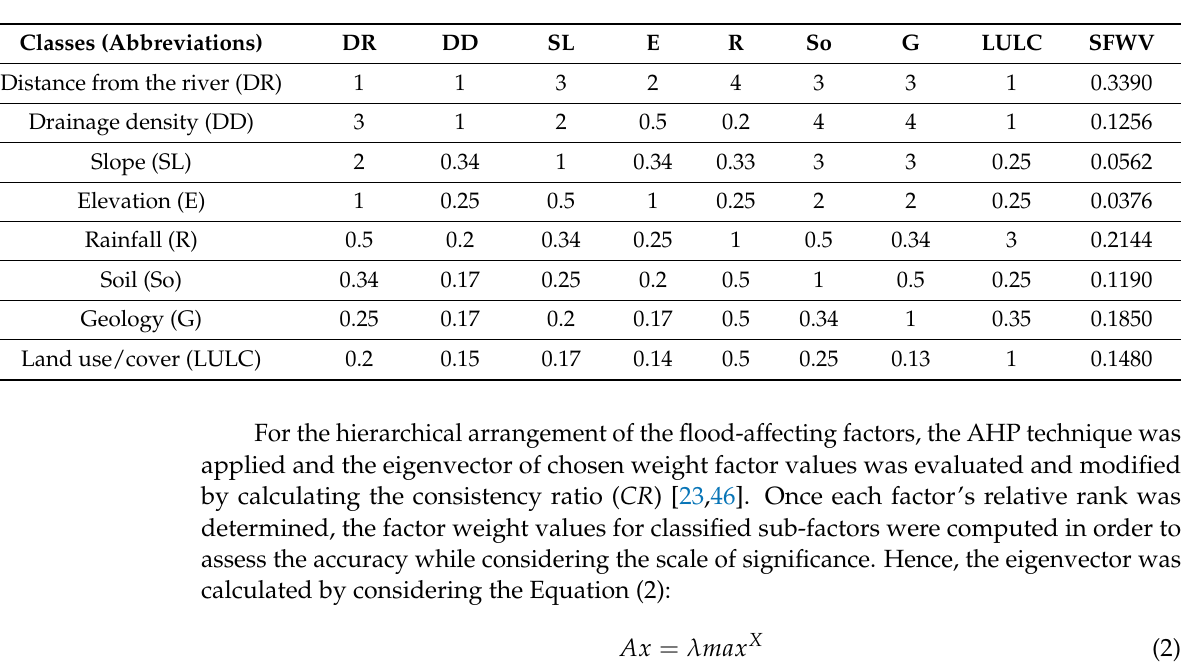
Table 3. For the flood susceptibility mapping, the flood-causing variables and their selected factor weight values (SFWVs) are